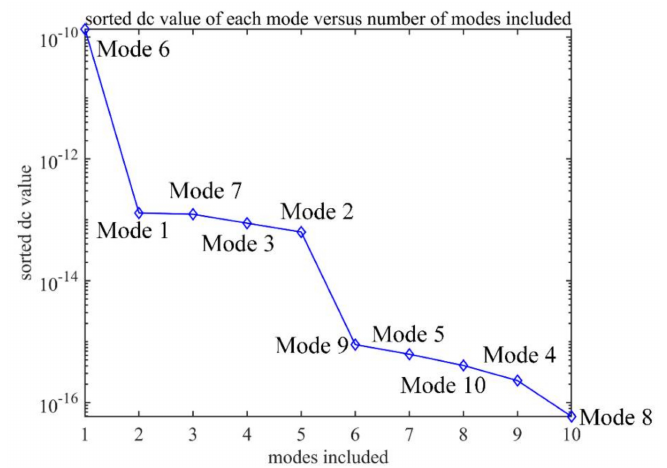
Figure 10. Sorted DC value of each mode versus number of modes